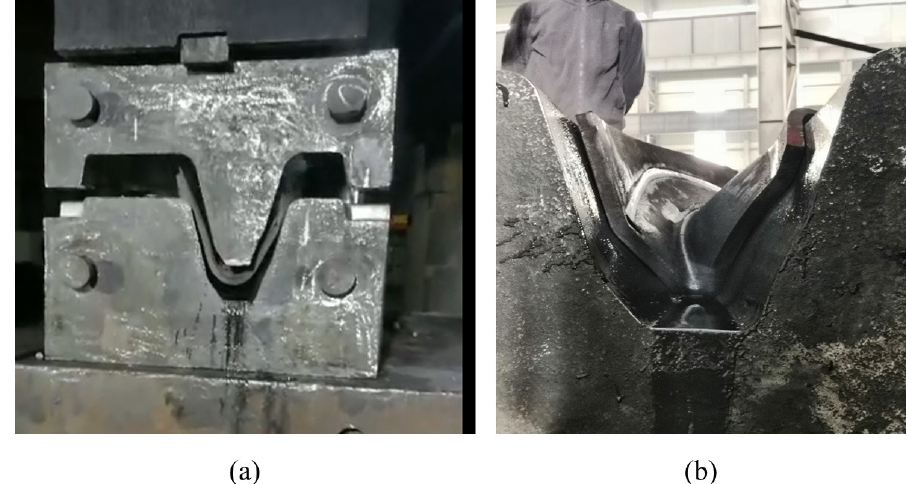
Figure 15. The trial hot forming process of the V-shaped part: (a) pressing process and (b) after unloading.